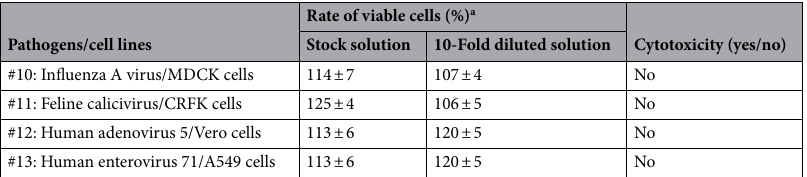
Table 2. Evaluation of the cytotoxicity of the disinfectant. MDCK Madin–Darby canine kidney, CRFK Crandell–Rees feline kidney. a Average value and standard deviation of 4 wells.